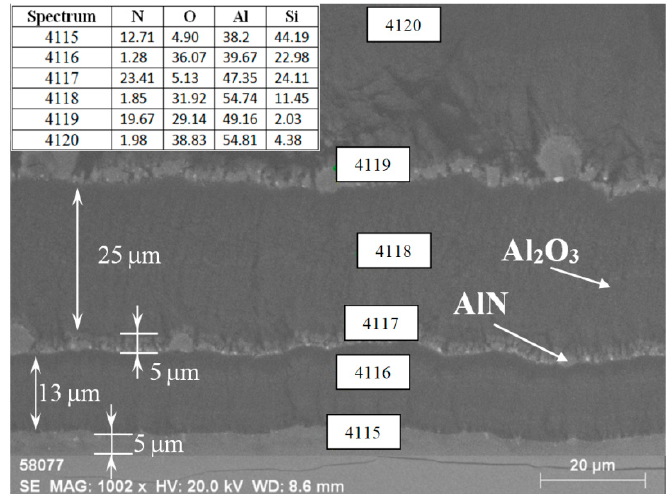
Figure 4. Micrograph of the silicon transversal section with deposited coatings based on alumina nitride and alumina oxide ceramics and the elemental composition (in weight percent) of the layers (in table inset). Numbers of the spectra acquisition regions are given as the first column in the table inset.